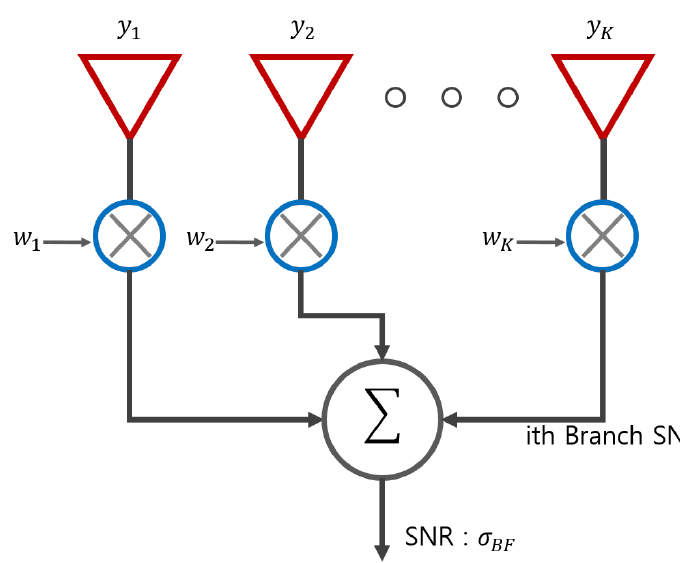
Figure 2. Example of a structure of the combining block diagram.